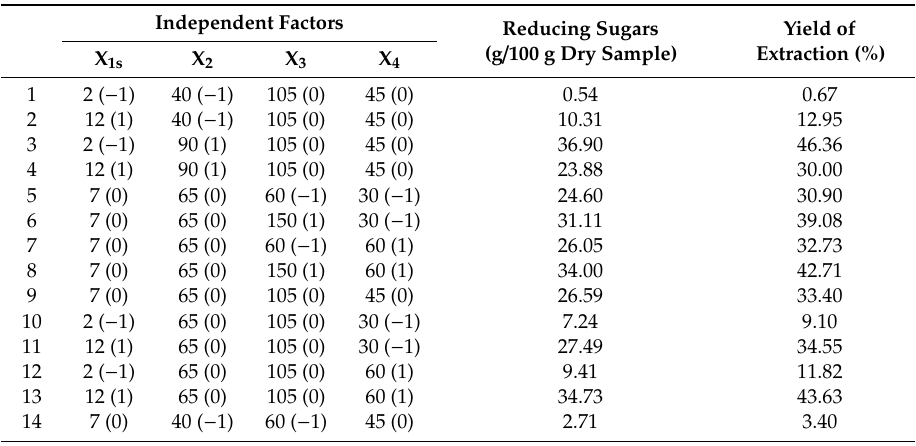
Table 2. Box–Behnken design with natural and coded values for chemical hydrolysis conditions with H 2 SO 4 and experimental values of reducing sugars quantified by Schoorl